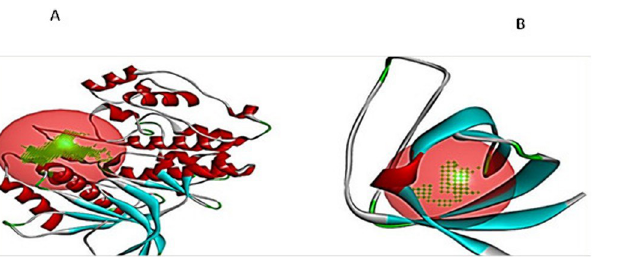
Fig 8. The binding site of the rust fungus. The MAKP1 of the leaf rust fungus and (B) the PGTG protein of stem rust.